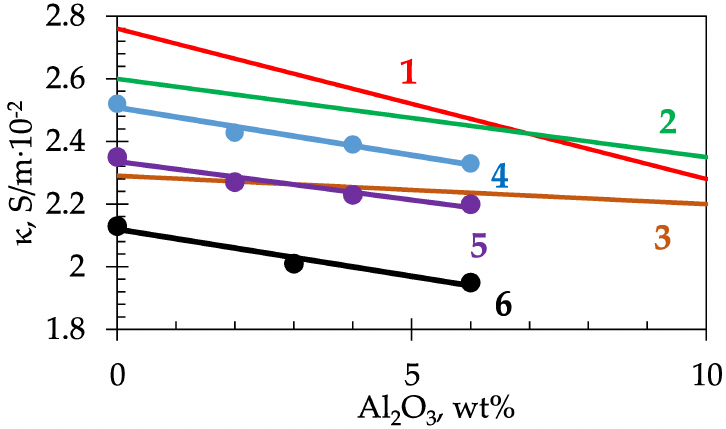
Figure 4. Electrical conductivity of cryolite melts, depending on the alumina concentration at T = 1273 K: 1—NaF-AlF 3 , CR = 3 [24]; 2—NaF-AlF 3 , CR = 2.4 [18]; 3—NaF-AlF 3 , CR = 1.8 [18]; 4—NaF-AlF 3 , CR = 2.4; 5—NaF-AlF 3 , CR = 2.1; 6—NaF-AlF 3 -(5 wt%) CaF 2 , CR =